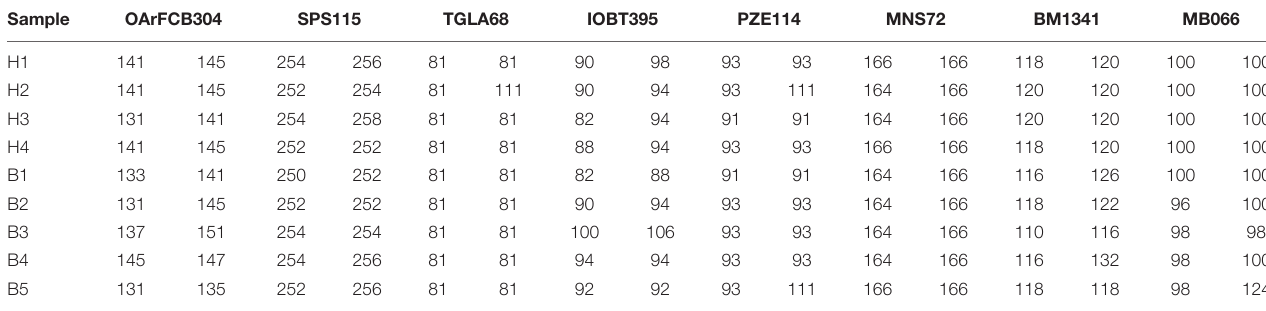
TABLE 1 | Detailed information for microsatellite loci of Mongolian gazelle.